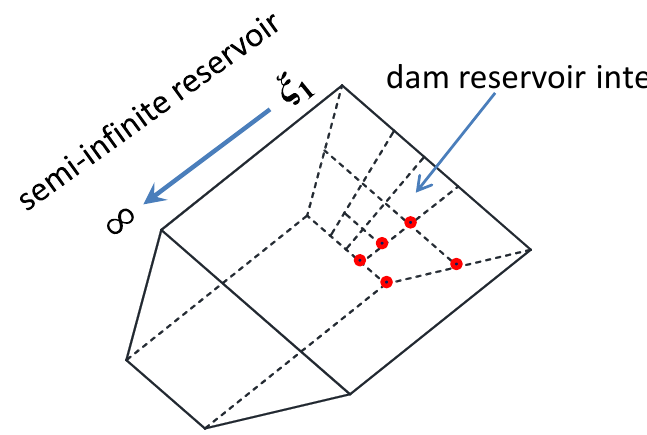
Figure 3. Reservoir model discretized by SBFEM.